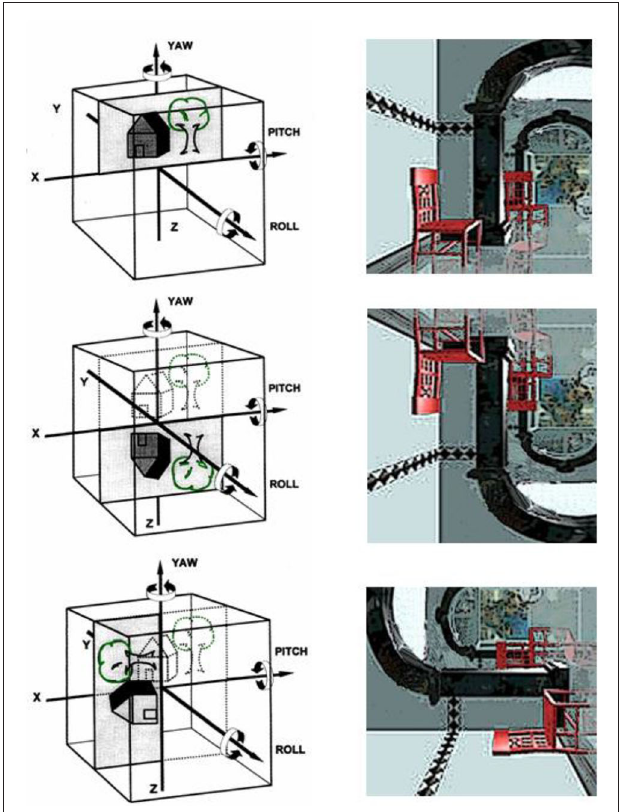
FIGURE 3 | Room-tilt illusion: schematic representation of the head as a cube with the cortical matching of the vestibular and the visual 3-D coordinate maps . The three major planes of action of the vestibular system are the frontal roll, the horizontal yaw, and the sagittal pitch about the x, y and z axes, respectively. (Top) Visual scene matches with the vestibular coordinates; (middle) room tilt illusion with 180 ◦ tilted visual scene in the pitch plane (upside-down vision); (bottom): room tilt illusion with 90 ◦ tilt in the roll plane (modified from Brandt, 1997).